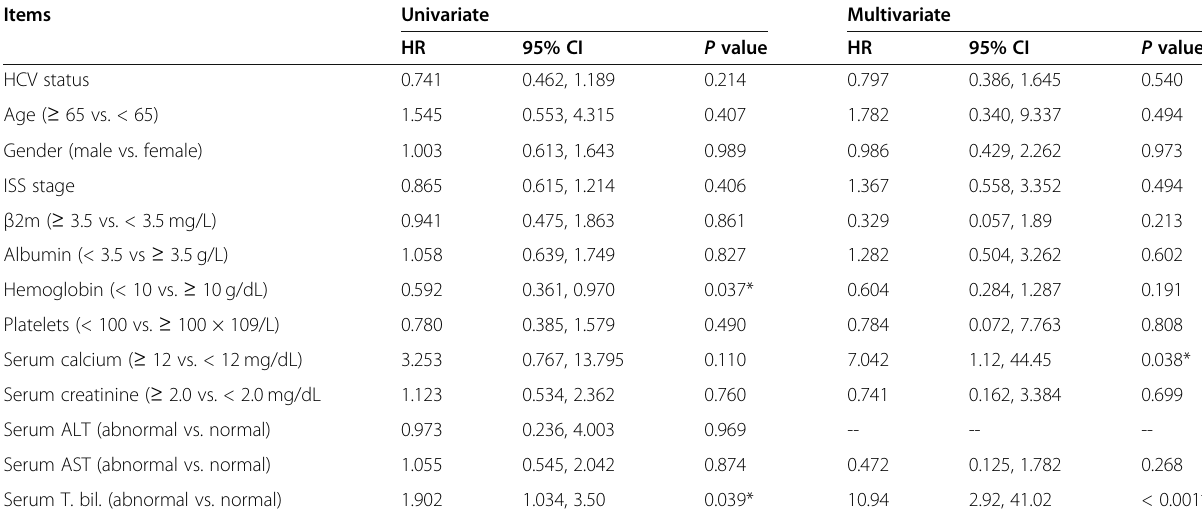
Table 4 Univariate and multivariate analyses for DFS in MM patients